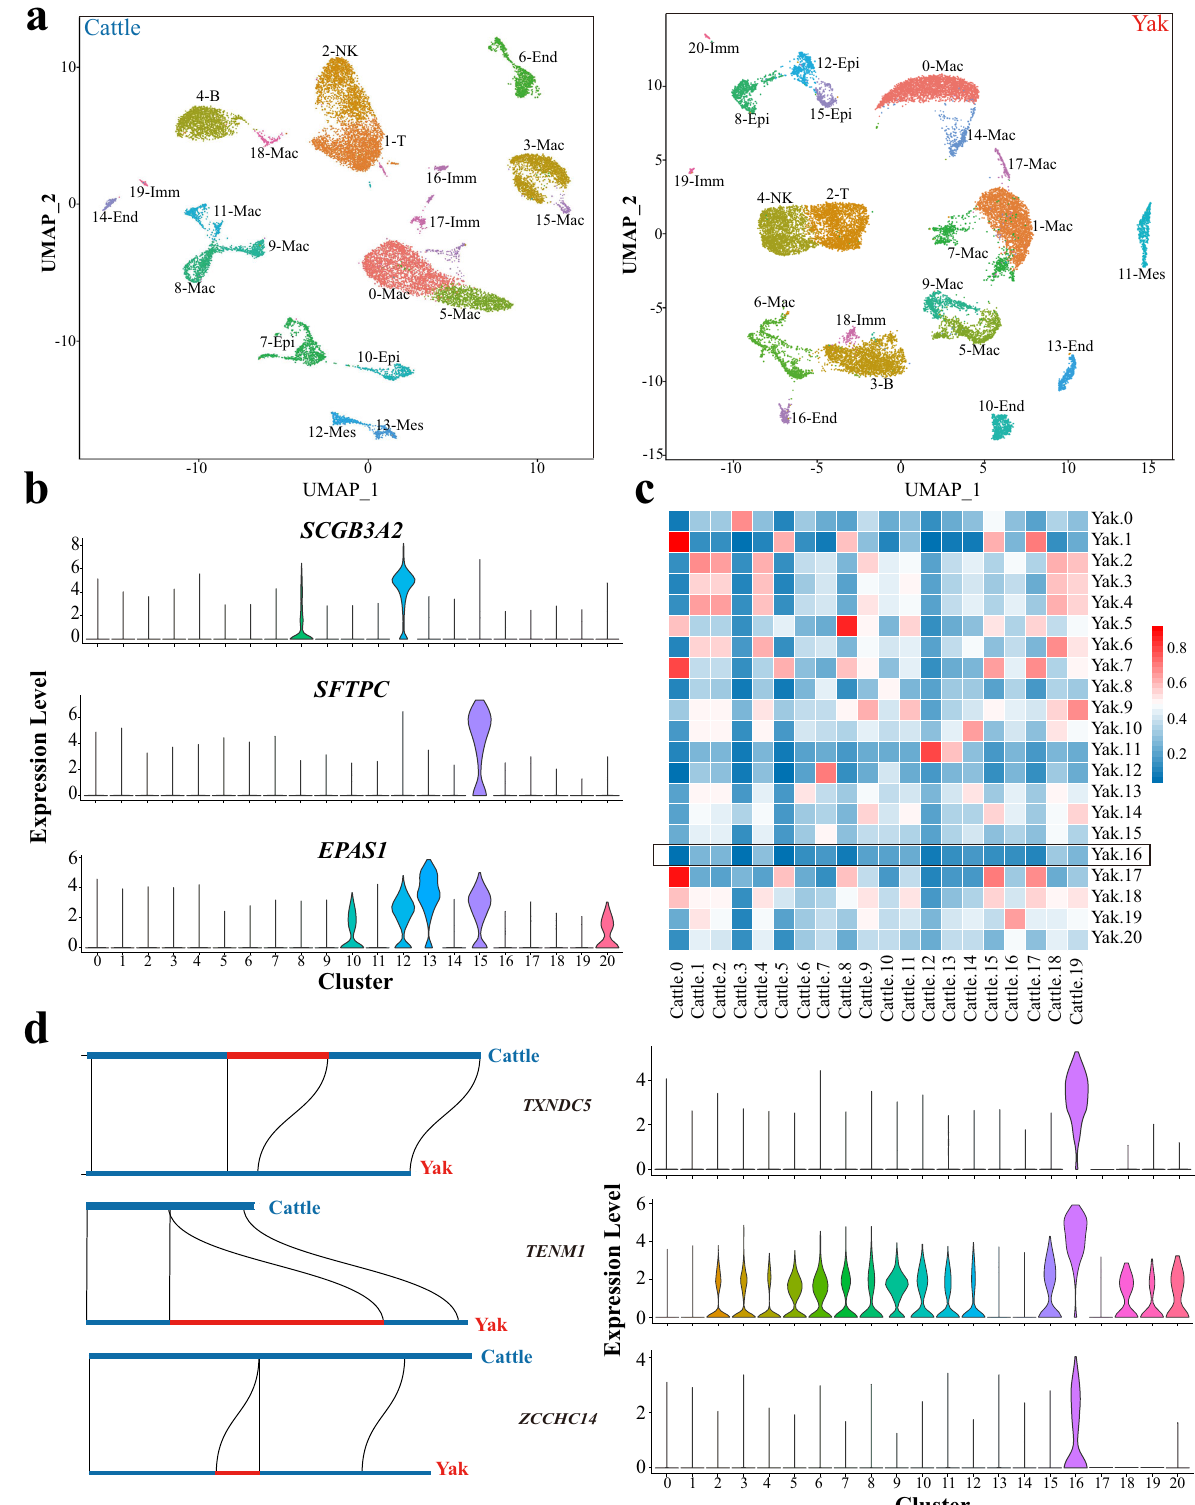
Fig.3|SinglecellRNAsequencing(ScRNA-seq)identi fi eddifferentcellclusters in taurine cattle and domestic yak lungs. a UMAP clustering of various cell clusters in taurine cattle (left, n = 5 biologically independent samples) and domestic yak lung (right, n = 5 biologically independent samples). b Violin diagram of the expressions of special marker genes in the domestic yak lung ( n = 5 biologically independent samples). c Heatmap of the pearson